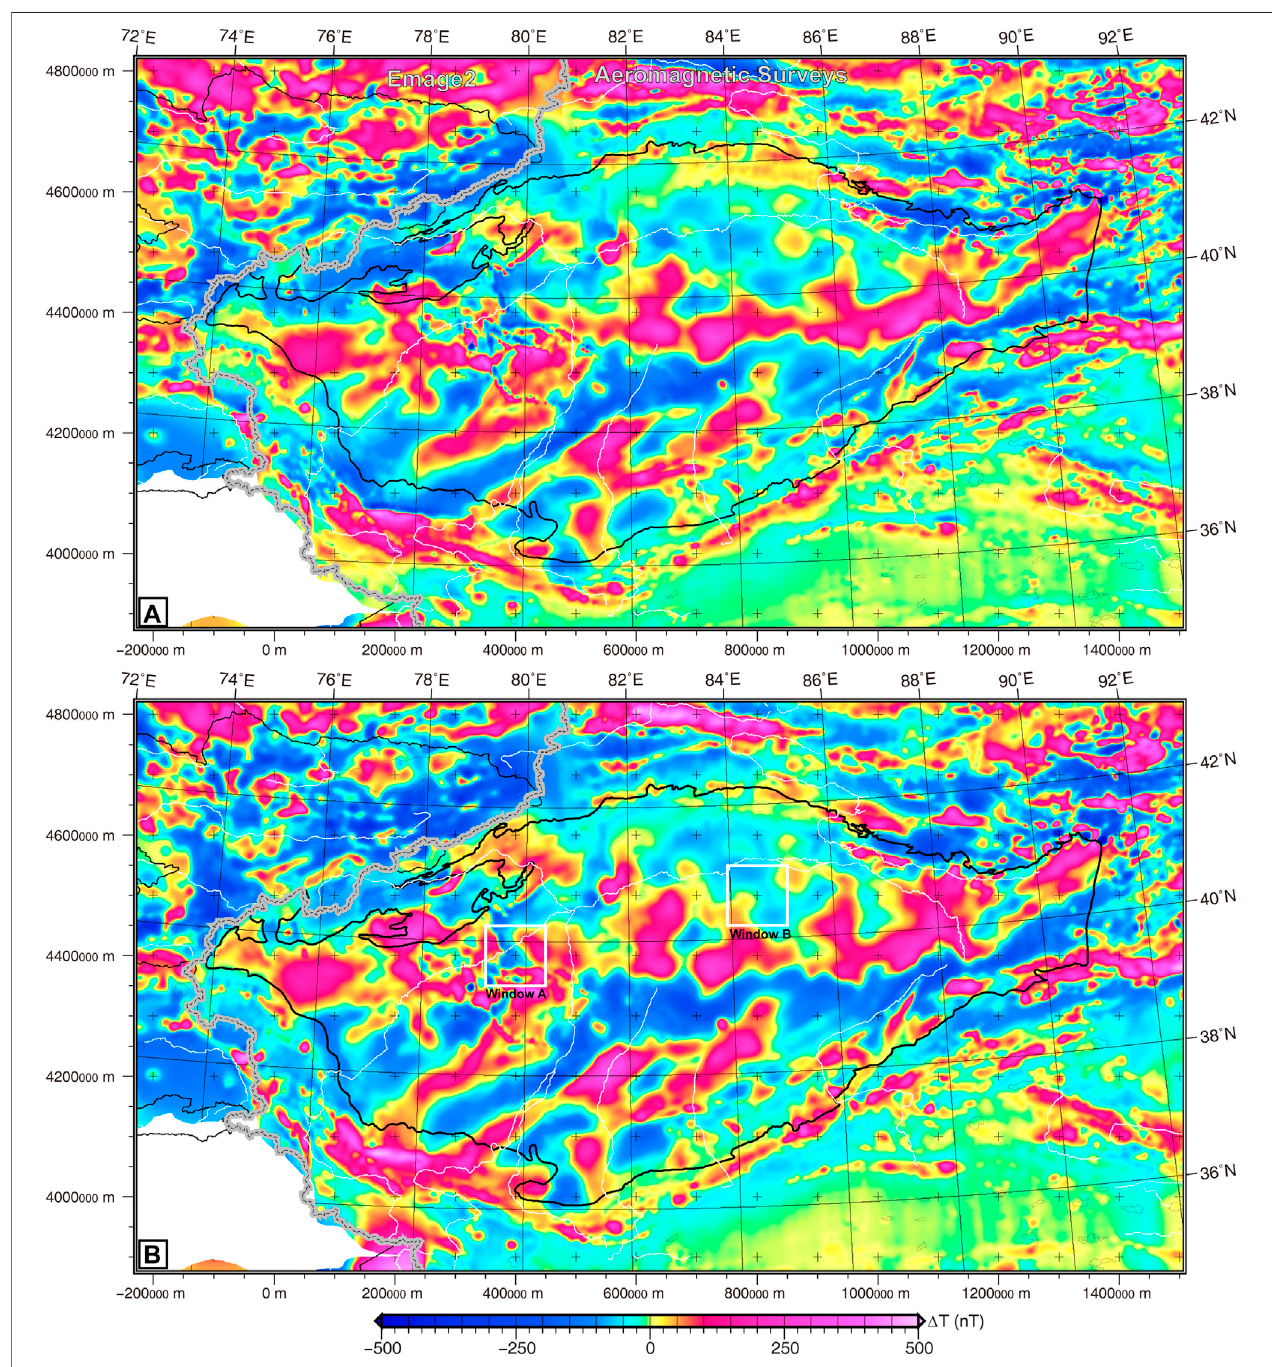
FIGURE 2 | (A) Total- fi eld magnetic anomalies dataset in the digital elevation model at an altitude of 1 km, comprising wholly aeromagnetic data within China (cell size,1 km) and partly magnetic grids ofEMAG2(http://www.geomag.org/models/emag2.html) with ∼ 3-km resolution outside thedashed grey-black line. Theblack line outlines the Tarim Basin. (B) Magnetic anomaly map with reduction to the pole (RTP). White patches are the regions without magnetic data.